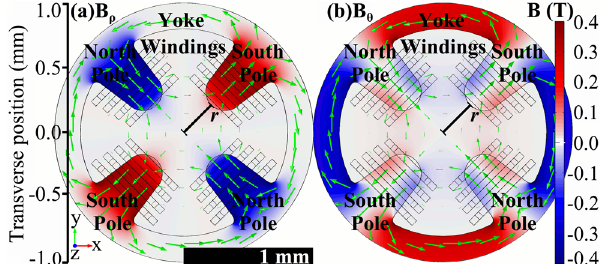
(quadrupole center) for I ¼ 1 A. Green arrows show the mag- netic field direction (length shows log-scale intensity). The field gradient integrated down the longitudinal axis was 0.025 Tat 1